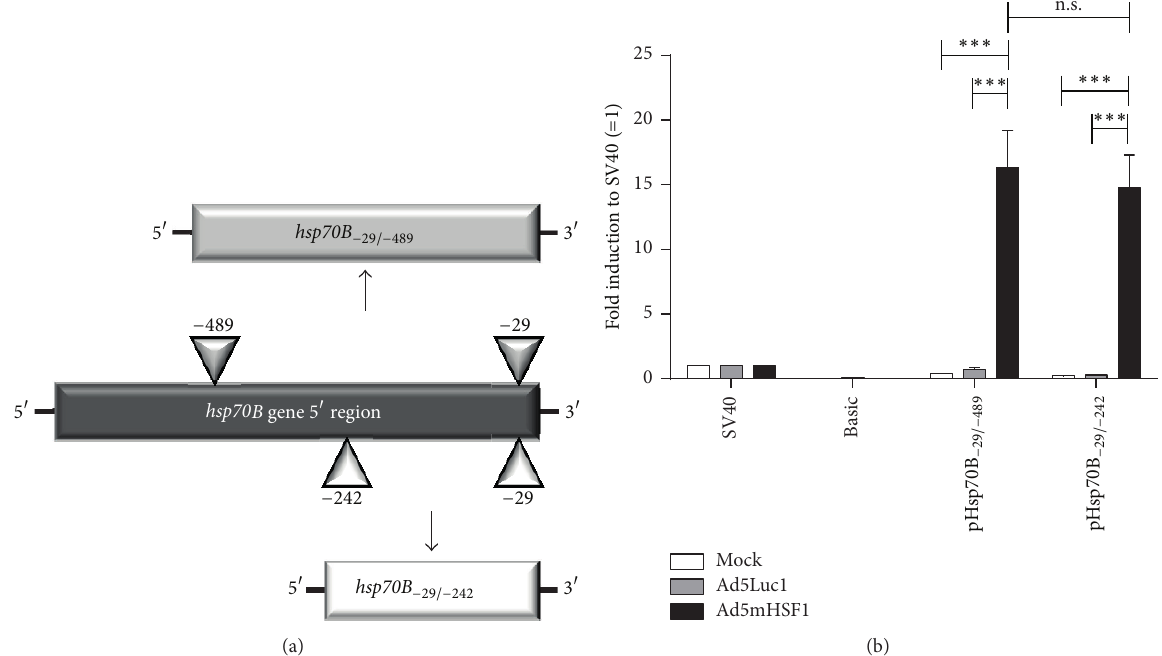
Figure 2: Generation and evaluation of two different Hsp70B heat shock response elements. (a) Plasmid vectors containing Hsp70B −29/−489 and Hsp70B −29/−242 were generated by digesting the human hsp70B gene 5 󸀠 -region with HindIII/BamHI or HindIII/SmaI, respectively, followed by ligation into the pGL3Basic vector. (b) HeLa cells were transfected with 0.5 𝜇 g of plasmid DNA of pGL3-SV40-promoter vector (“SV40”), promoterless pGL3-Basic vector (“Basic”), pHsp70B −29/−489 , or pHsp70B −29/−242 . The next day, cells were either left untreated (“Mock”) or transduced with adenoviruses Ad5Luc1 or Ad5mHSF1 at 300 TCID 50 /cell. Twenty-four hours later, cells were harvested and analyzed by luciferase reporter assays. Results are shown as fold induction relative to the individual pGL3-SV40-promoter control containing no virus, Ad5Luc1 or Ad5mHSF1. Data are mean ± SEM of three independent experiments. ∗∗∗ 𝑃 < 0.001 , n.s.: not significant ( 𝑃 > 0.05 ); bars without annotation are not significant ( 𝑃 > 0.05 ); two-way ANOVA with Bonferroni’s Multiple Comparison post hoc